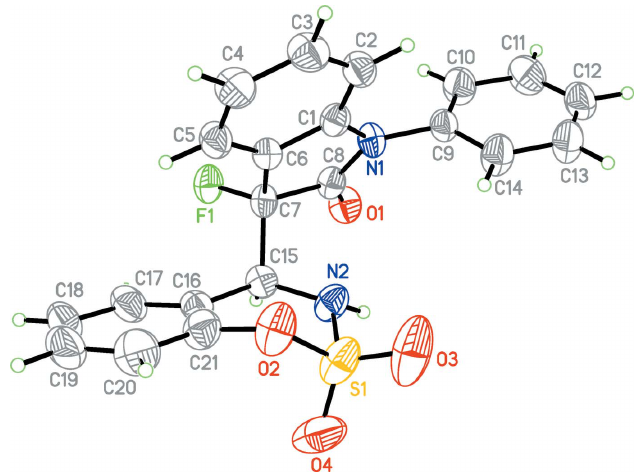
Figure 1 The molecular structure of the title compound. Displacement ellipsoids are drawn at the 50% probability level. Only the major disorder component is